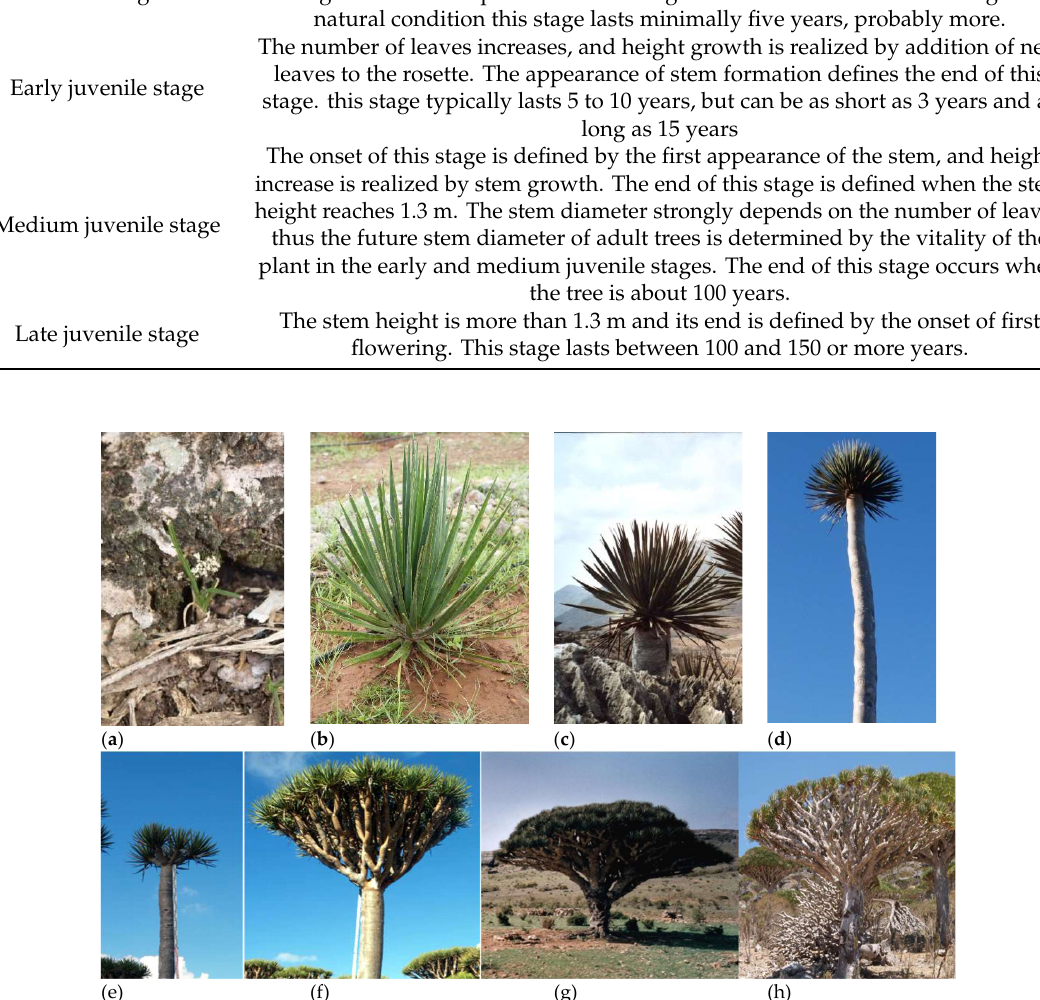
Table 1. Description of juvenile stages of D. cinnabari (according to Maděra et al., [113]).